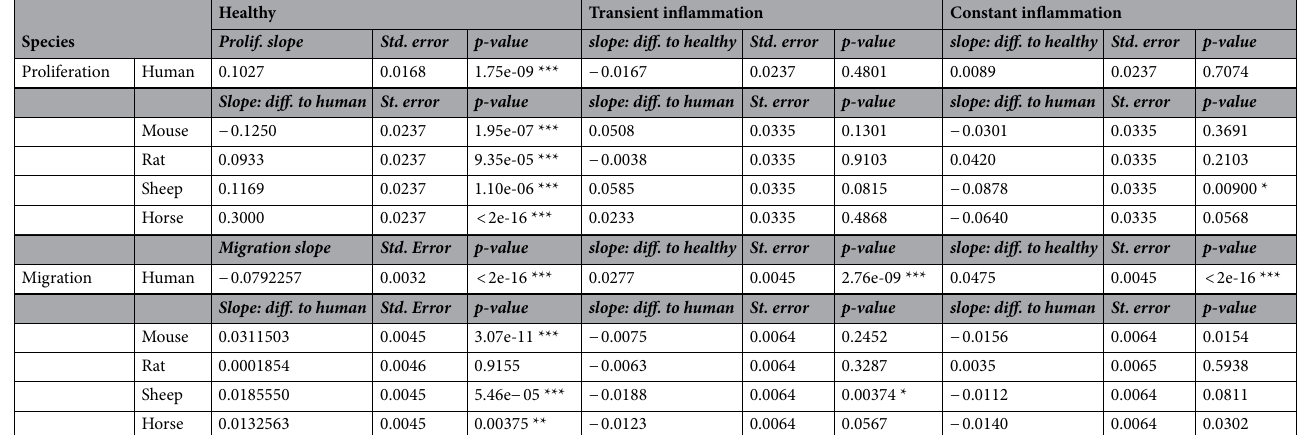
Table 1. The first column corresponds to the healthy situation, the second and third to transiently and constantly inflamed, respectively. First rows (human) correspond to tests for non-zero slopes of the proliferation and migration curves in humans, i.e., either non-zero proliferation or non-zero gap closure in humans. Second to fifth rows (different animal species) correspond to tests of differences of the animal models to humans in the slopes of the proliferation and migration curves of tenocytes. Calculations used an ANCOVA. Means, standard errors and p-values are reported. To correct for multiple testing with four comparisons using Bonferroni, the nominal significance levels (0.05, 0.01, and 0.001) are set to the corrected levels (0.0125, 0.002, 0.0002, respectively). P-values are marked with stars from * (significant) to *** (highly significant) using this